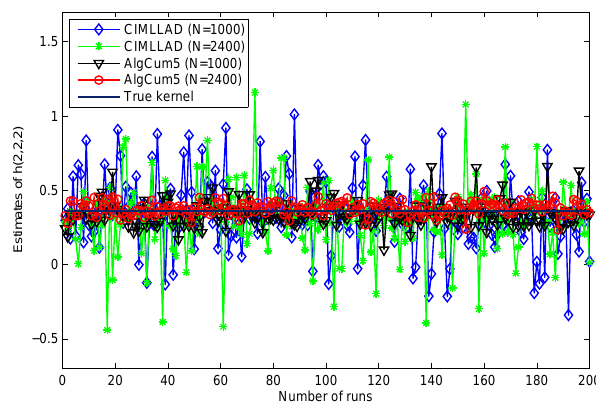
Figure 10. Estimated cubic kernel, h ( 2,2,2 ) = 0.36, for system